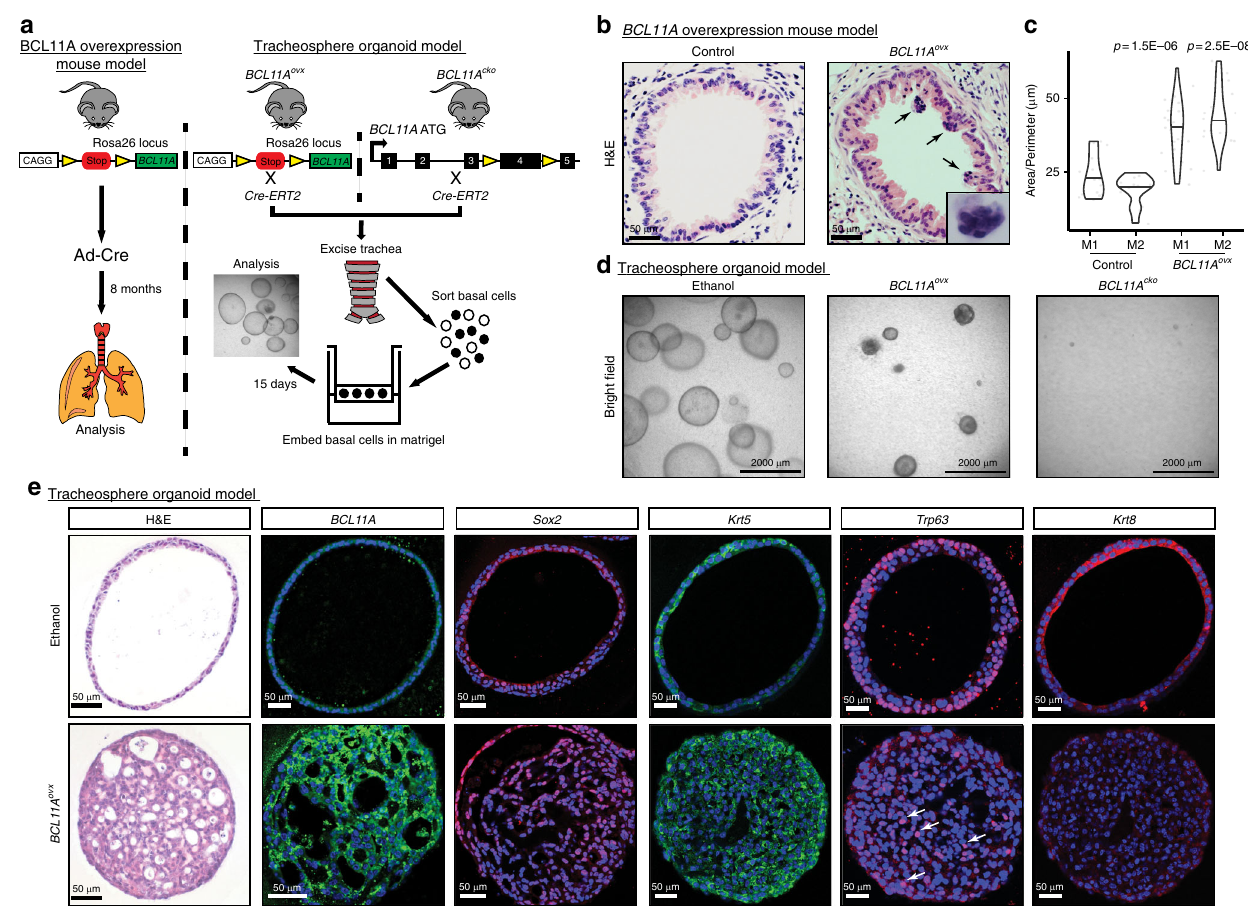
Fig. 2 BCL11A overexpression leads to thickening of the airways and abnormal organoid formation. a Schematic representing strategy to explore the role of BCL11A in vivo and ex vivo. Left Panel: Adenovirus-Cre was nasally administered to BCL11A ovx mice and the lungs were analysed after eight months. Right panel: for the tracheosphere organoid model, basal cells from the trachea of either BCL11A ovx or BCL11A cko mice were FACS sorted, embedded in matrigel and analysed after 15 days. Three independent mice were used for each experiment. b Images of airways from control and BCL11A ovx . Arrows indicate small hyperchromatic cells with irregular nuclei. c Quanti fi caiton of airway epithelial layer hyperplasia from two control and BCL11A ovx mice. d Bright fi eld images of organoids from Bcl11a cko and BCL11A ovx mice treated with vehicle or tamoxifen. e Sectioned organoids from BCL11A ovx mice stained with haematoxylin and eosin, BCL11A, Sox2, Krt5, Trp63 and Krt8. Arrows indicate positive staining. Scale bar indicates 50 μ